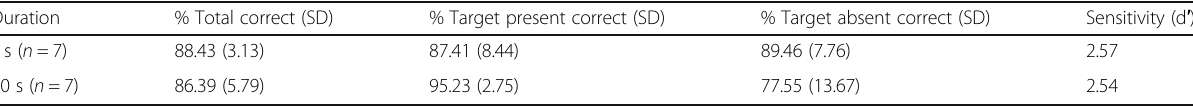
Table 8 Experiment 3: Mean percentage accuracy and sensitivity for the detection task ( n = 14) Duration % Total correct (SD) % Target present correct (SD) % Target absent correct (SD) Sensitivity (d ′